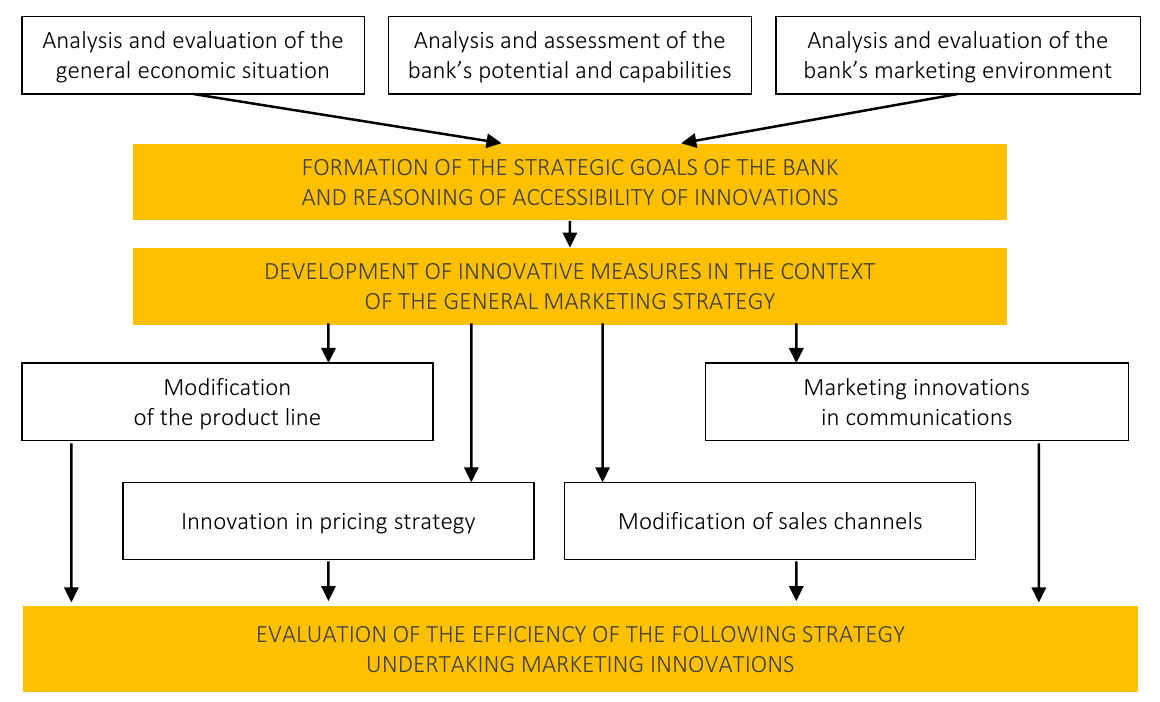
Figure 5. Innovations in the bank’s marketing